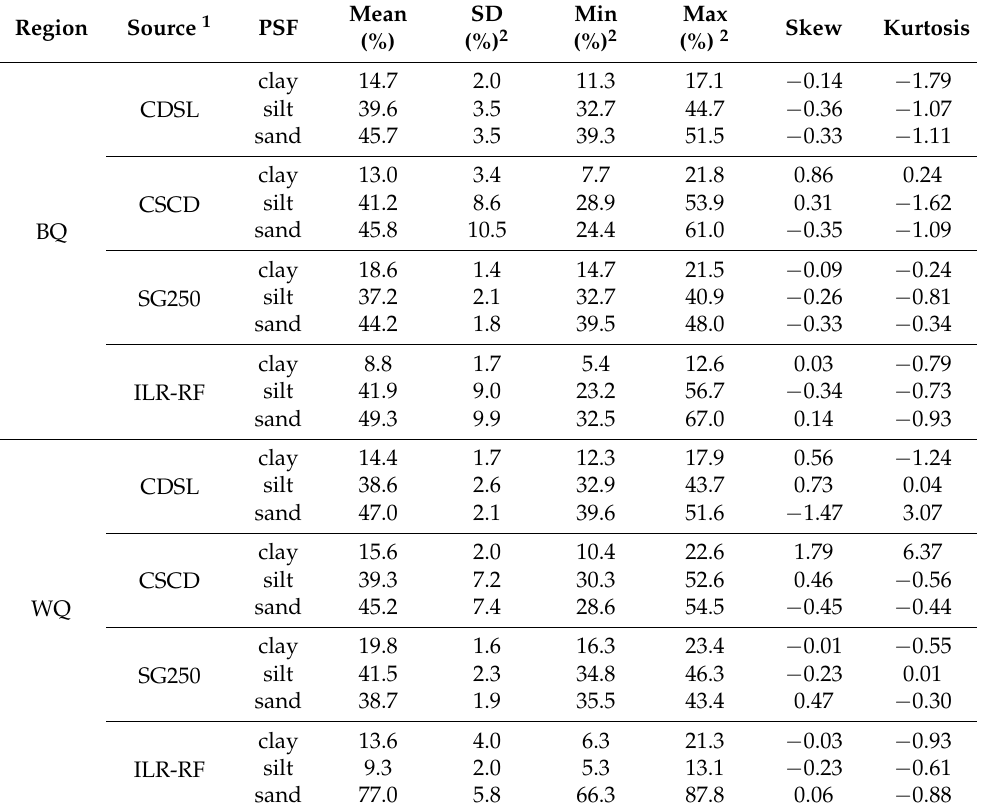
Table 4. Descriptive statistics of soil particle size